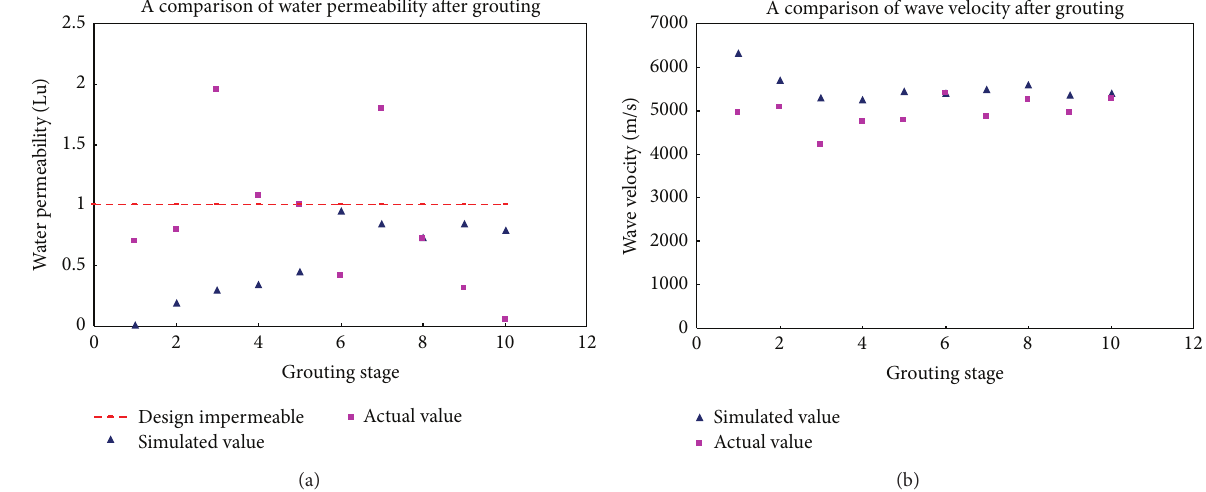
Figure 4: Comparison of the grouting effect after grouting with 1m as the design diffusion radius.